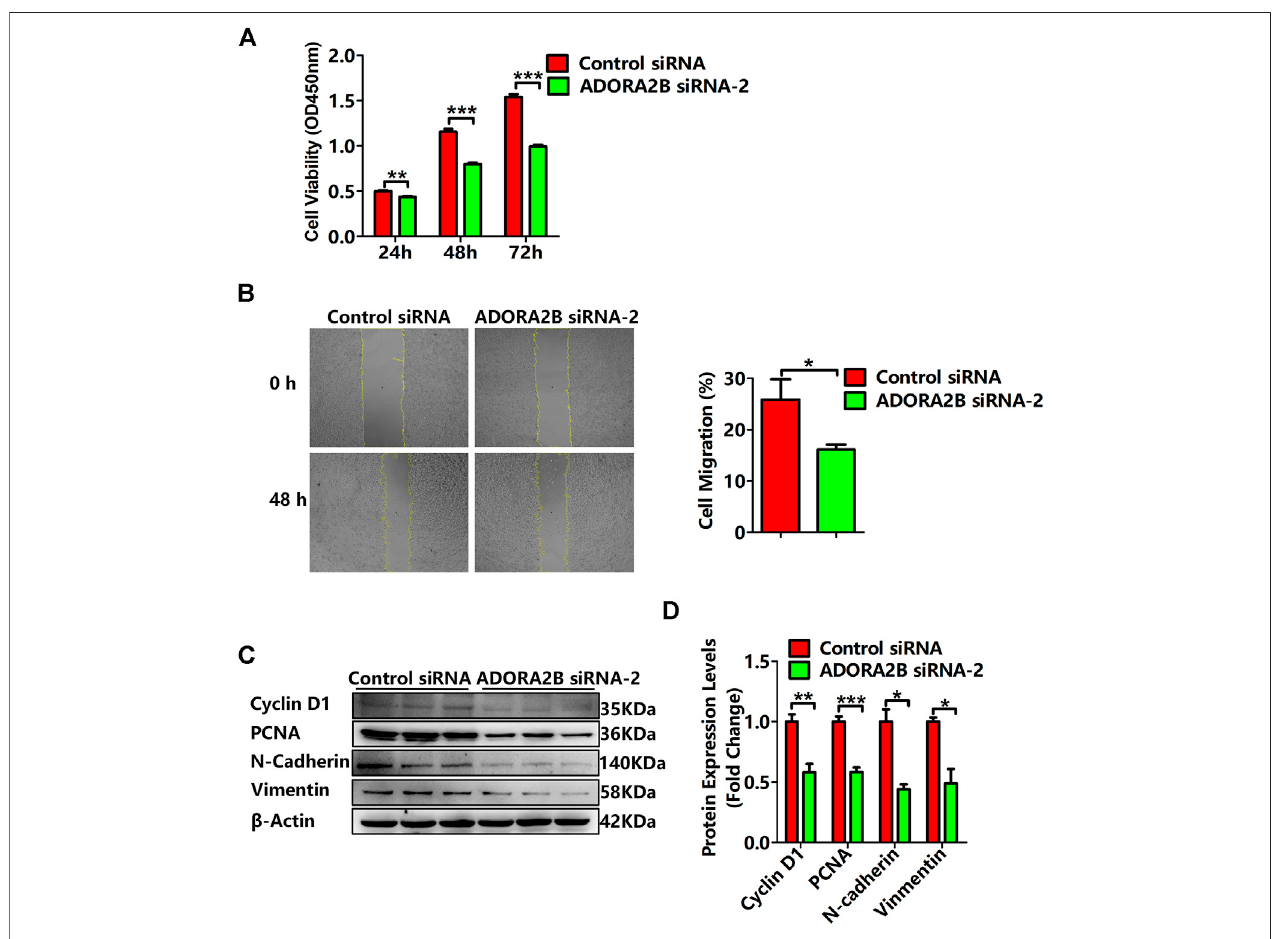
FIGURE 9 | Knockdown of ADORA2B inhibited the proliferation and metastasis of LUAD cells. (A) The cell viability of LUAD cells transfected with control or ADORA2B siRNA was detected by the CCK-8 assay. (B) The wound healing assay was used to examine the effect of ADORA2B siRNA on A549 cell migration for 48 h (magni fi cation: × 40). (C) Relative protein expressions of proliferative (cyclin D1 and PCNA) and metastatic (N-cadherin and vimentin) markers were determined by western blotting. (D) Protein quantitative statistics. * p < 0.05, ** p < 0.01, and *** p < 0.001 are statistically signi fi cant.